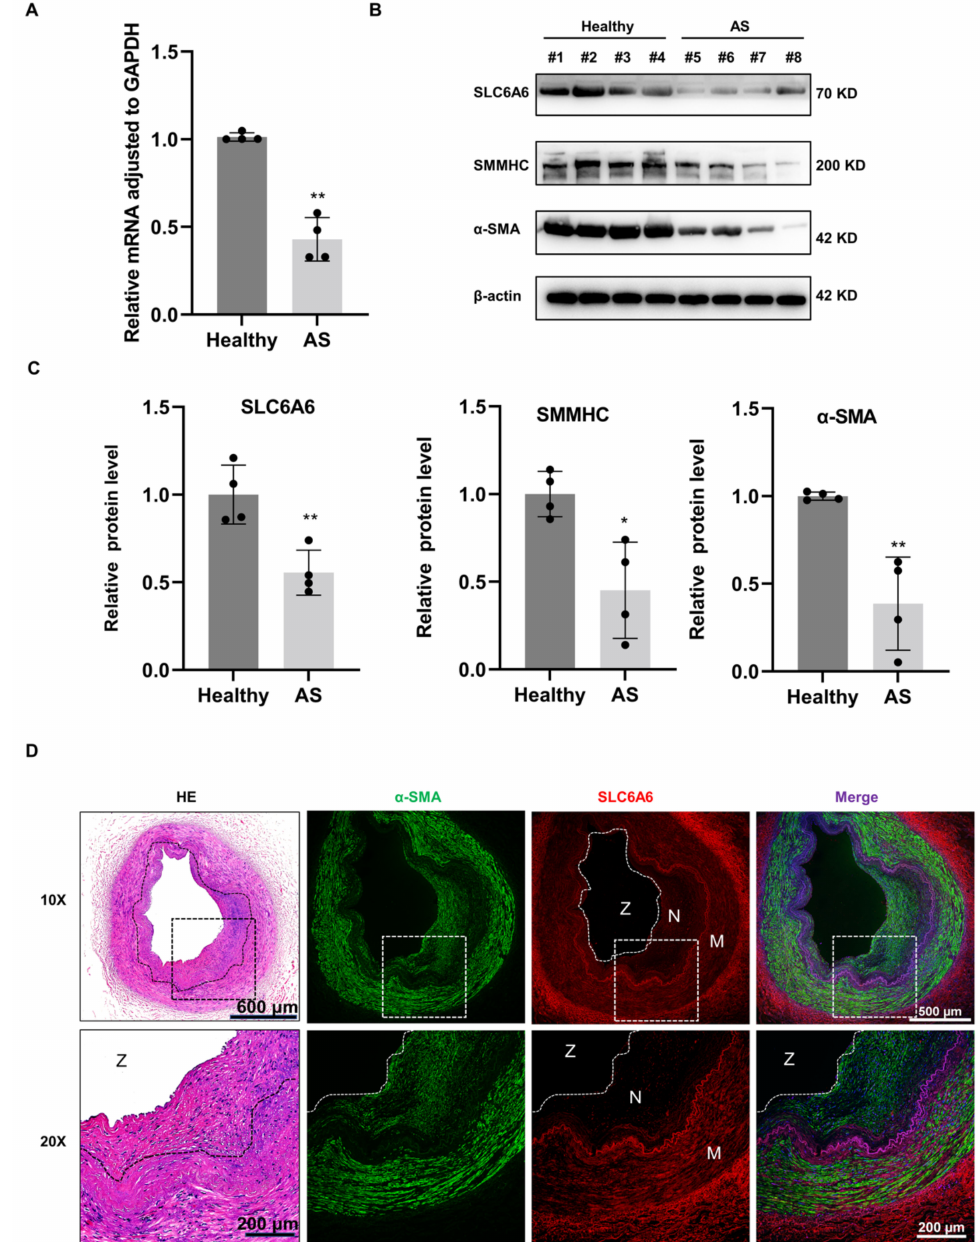
Figure 3. SLC6A6 expression was decreased in atherosclerotic arteries. ( A ) qRT‑PCR analysis show‑ ing SLC6A6 mRNA expression levels in healthy and atherosclerotic arteries (AS). Data are